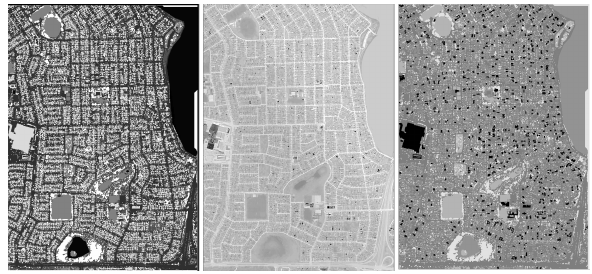
Figure 3. LWIR images in white-hot color scale of area 2. Left: Simulated temperatures. Middle: Measured LWIR image. Right: Simulated LWIR